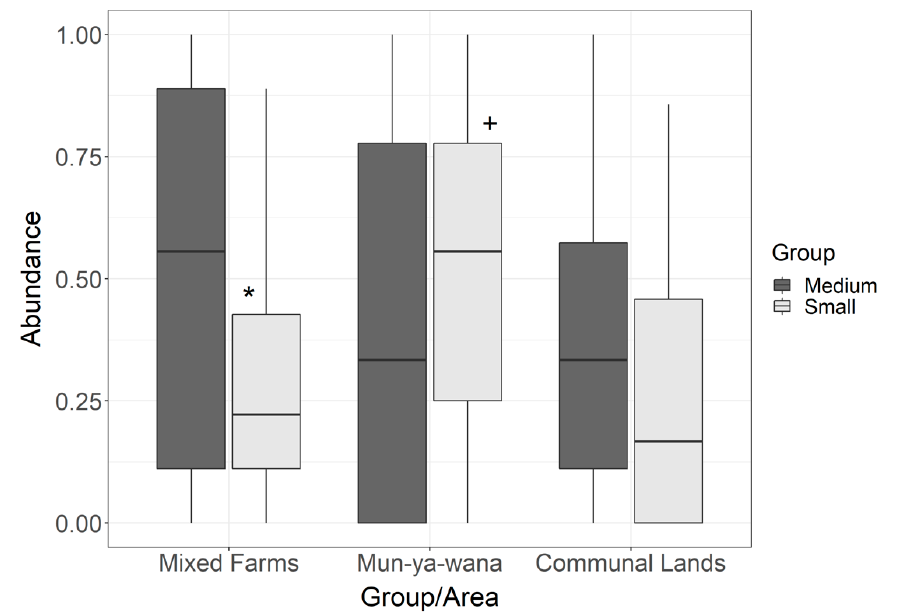
Figure 3. Boxplot of medium and small rodents’ relative abundance in the three management-type zones monitored: game (mixed) farms, Mun-ya-wana game reserve and communal lands. Based on the GLM test, * indicates a significant difference between size-based groups in mixed farms ( p = 0.011), + indicates a significant difference between Mun-ya-wana game reserve and remaining areas for small rodents ( p = 0.016).